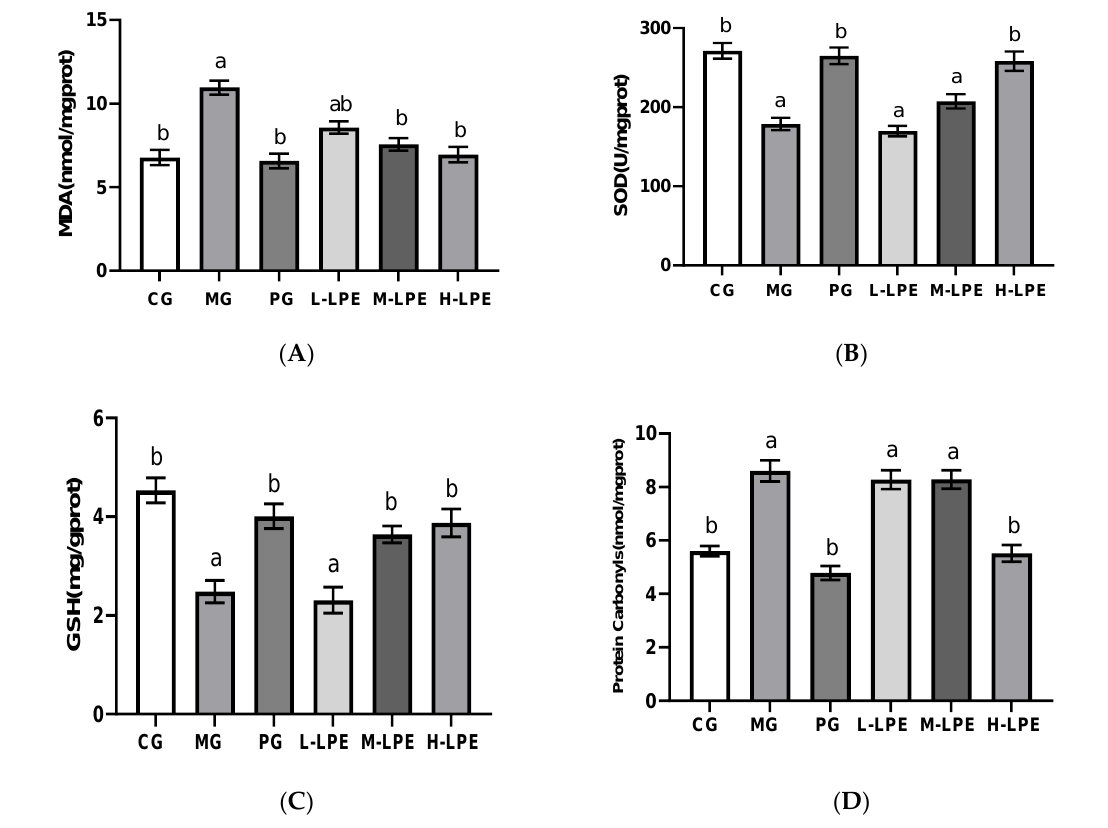
Figure 4. MDA, SOD, GSH, and protein carbonyls levels in the liver of mice: ( A ) MDA content in the liver of mice; ( B ) SOD activity in the liver of mice; ( C ) GSH contents in the liver of mice; ( D ) protein carbonyls content in the liver of mice. Values are expressed as mean ± standard error ( n = 12 in each group). Values with different superscripts showed a difference with statistical significance, p < 0.05, “a” as a statistical difference compared with the blank control group, “b” as a statistical difference compared with the model group.